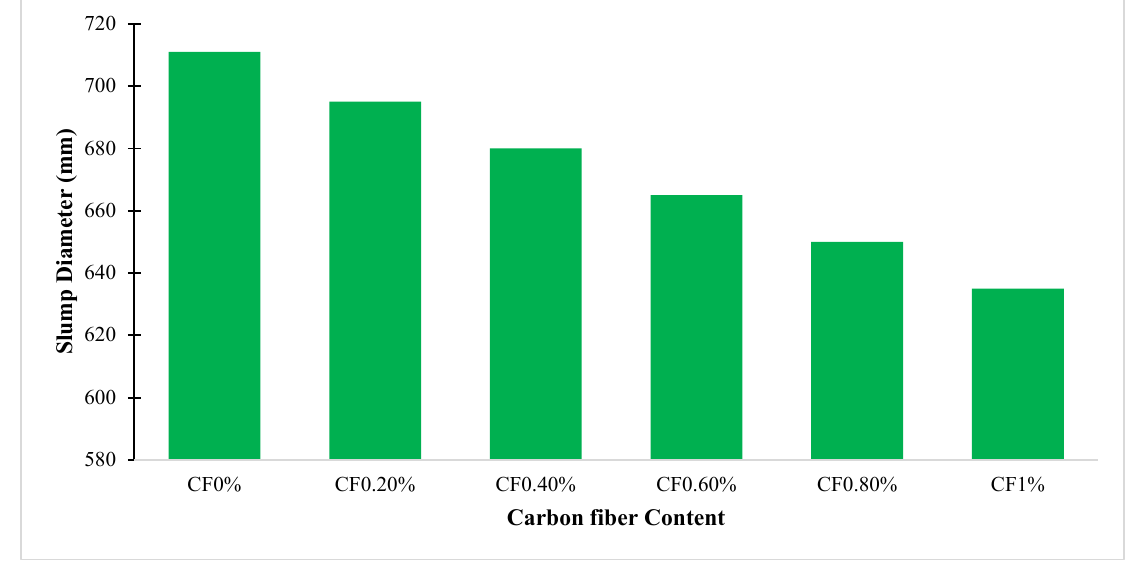
Figure 2. Slump flow Test.